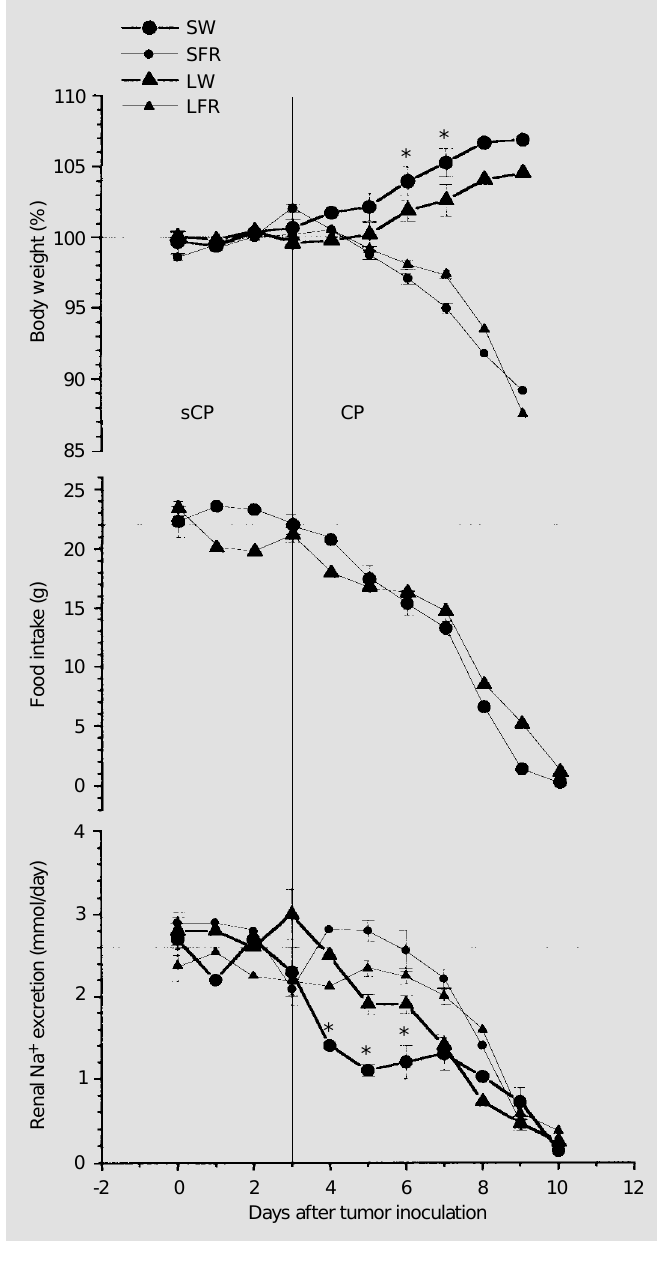
Figure 2 - Time course of the changes in body weight and renal Na + excretion in septal-lesioned tumor-bearing rats (LW; N = 15) compared with sham- operated tumor-bearing rats (SW; N = 7) and their respective non-tumor- bearing controls, sham-operated food-restricted (SFR; N = 7) and lesioned food-restricted (LFR; N = 10) rats. Food intake is given for the SFR and LFR groups. During the clinical period (CP), body weight gain and renal Na + excre- tion in LW rats were temporarily altered in relation to the SW rats (LSD test, *P<0.05 for SW x LW). sCP, Subclinical